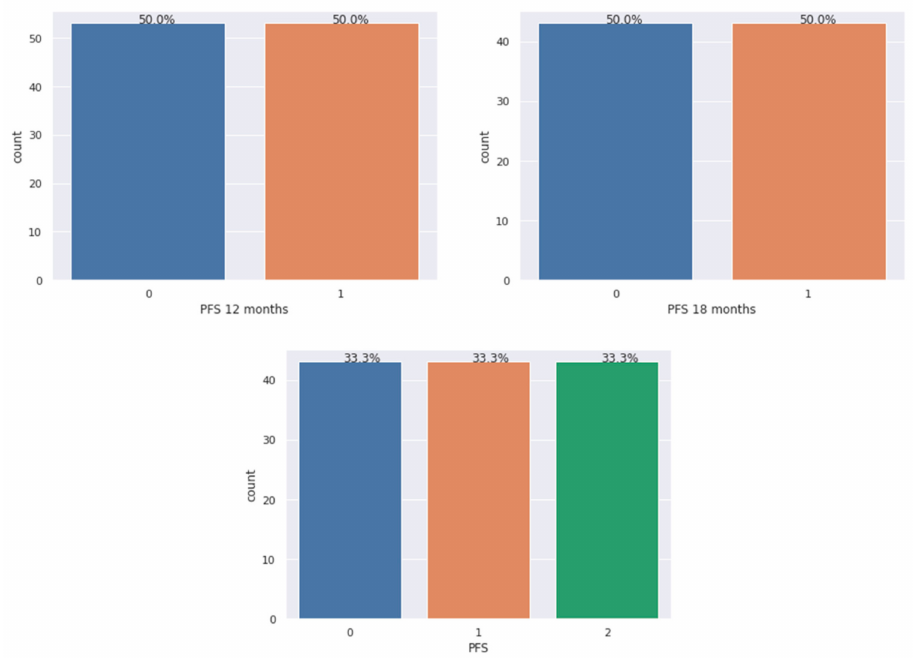
Figure 2. Balanced dataset after applying SMOTE. From the left: model 1—PFS 12 months, model 2—PFS 18 months, model 3—PFS.